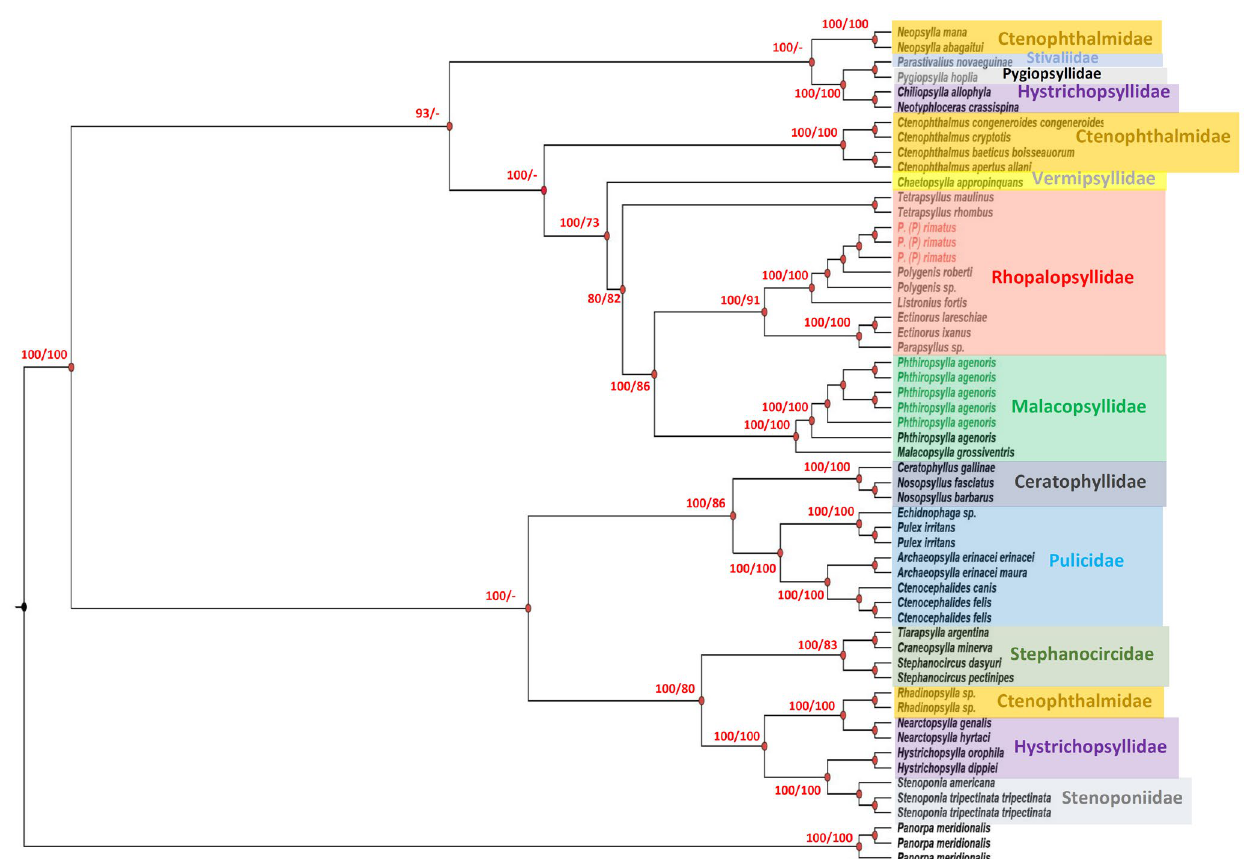
Figure 3. Phylogenetic tree of P. agenoris (bold and green) and P. (P) rimatus (bold and red) specimens assessed in this study (see Table 1). This analysis was based on concatenated sequences of partial elongation factor 1 alpha ( EF1−α ) from nuclear DNA and partial cytochrome c oxidase subunit 1 ( cox 1), cytochrome c oxidase subunit 2 ( cox 2) and cytochrome b ( cyt b) genes from mitochondrial DNA inferred using the Bayesian inference (BI) and maximum likelihood (ML) methods and Bayesian topology. The percentage of replicate trees in which the associated taxa clustered together in the bootstrap test (1000 replicates) is shown on the branches (BPP/bootstrap). The Bayesian posterior probabilities (BPPs) are converted to percentages. BPP and bootstrap values lower than 60% are not shown.